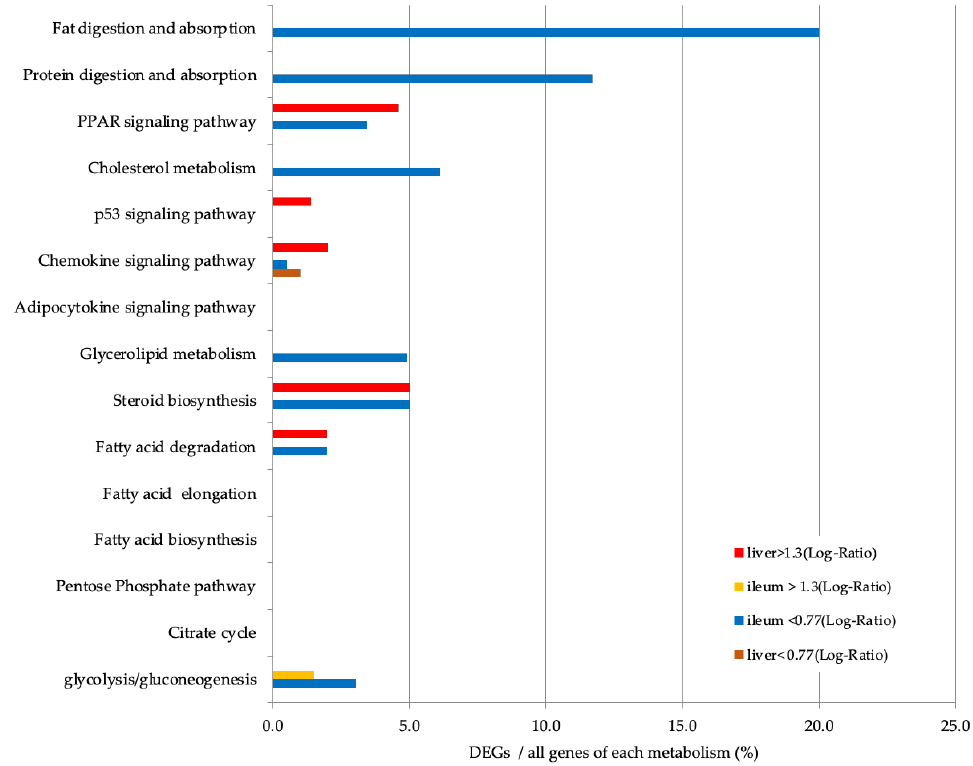
Figure 6. Percentage of upregulated (>1.3-fold difference to the control) and downregulated (<0.77-fold difference to the control group) differentially expressed genes (DEGs) in the liver and ileum. The y-axis shows the lipid metabolic pathway described in the Kyoto Encyclopedia of Gene and Genome (KEGG). The x-axis shows the percentage of DEGs per total genes involved in each pathway.